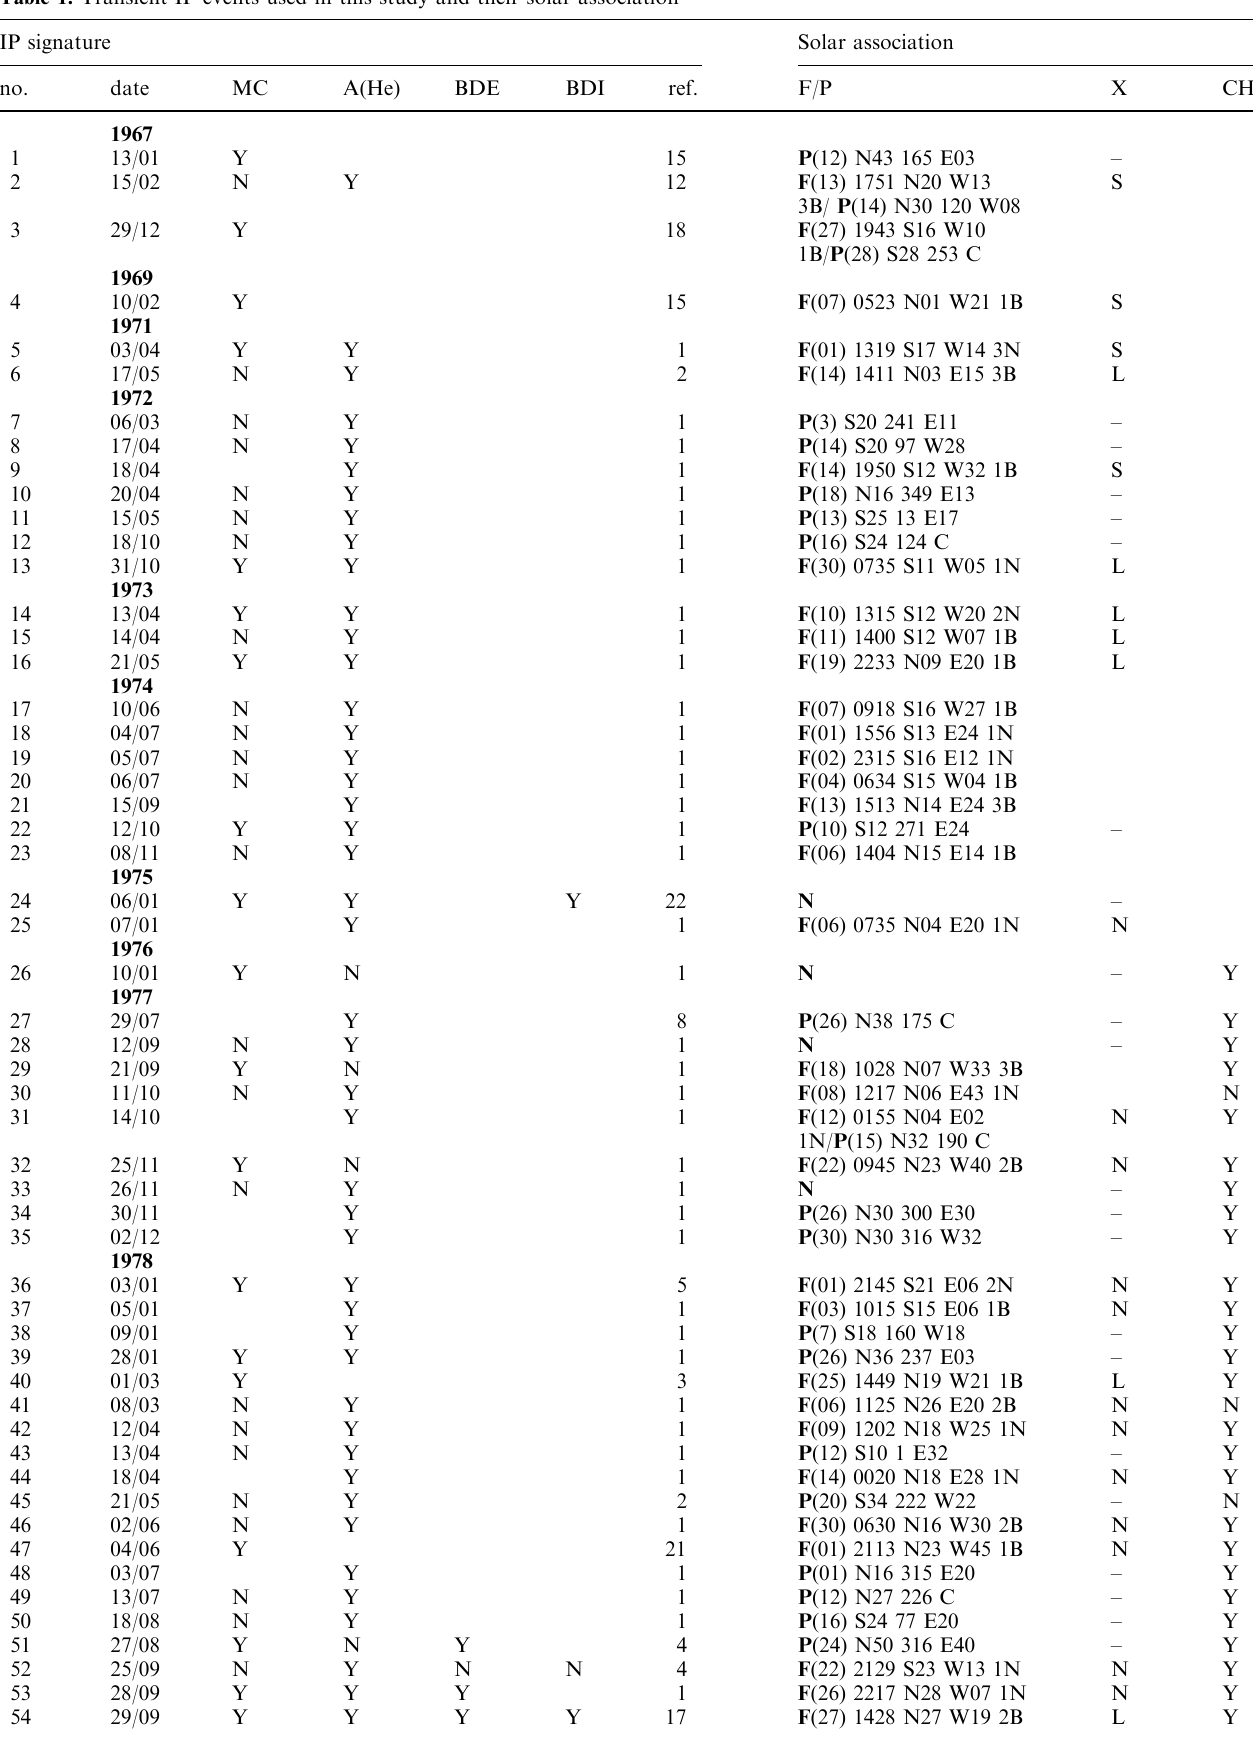
Table 1. Transient IP events used in this study and their solar association IP